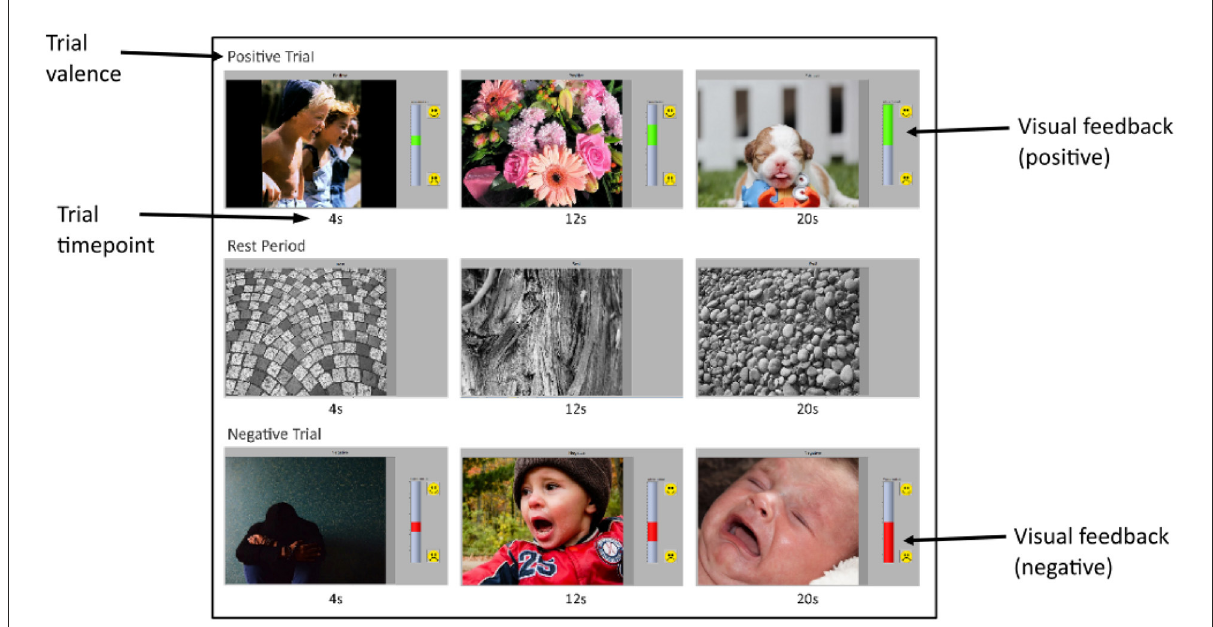
FIGURE3 Screenshots of experimental interface. Each row shows three screenshots, taken at 4, 12, and 20-s of an emotion-induction (or rest) trial. The top, middle, and bottom rows show a positive trial, rest period and a negative trial, respectively. Each screenshot shows the stimulus image being presented at that time in the trial, the valence prompt above it, and the feedback bar on the right. Stimulus images were taken from the IAPS (Lang et al., 2008), GAPED (Dan-Glauser and Scherer, 2011), and OASIS (Kurdi et al., 2017) affective image databases. For the positive trial, the feedback bar is green and increasing in height, representing an increasing probability the incoming signal belongs to the positive class as the trial proceeds. Similarly, the feedback bar is red and decreasing in height for the negative trial, indicating an increasing probability that the incoming signal belongs to the negative class as the trial proceeds. The rest trial has no visual